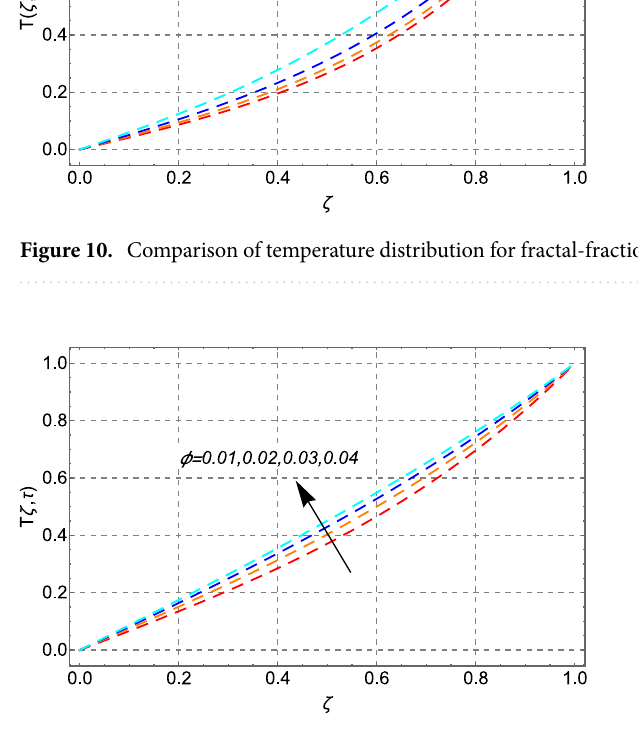
Figure 11. Impact of volume fraction of cadmium telluride nanoparticle φ on temperature distribution.